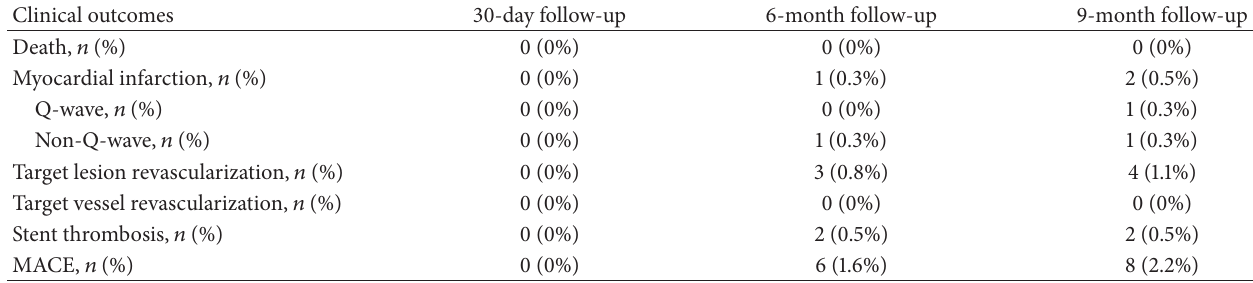
Table 3: Cumulative major adverse cardiac events at 30-day, 6-month, and 9-month follow-up. Clinical